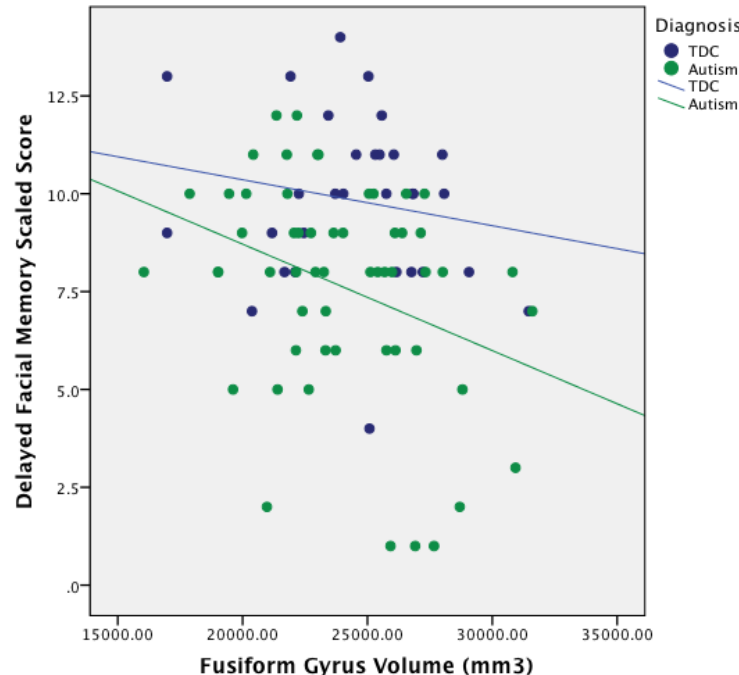
Note: TDC = Typically Developing Controls. mm3 = millimeters